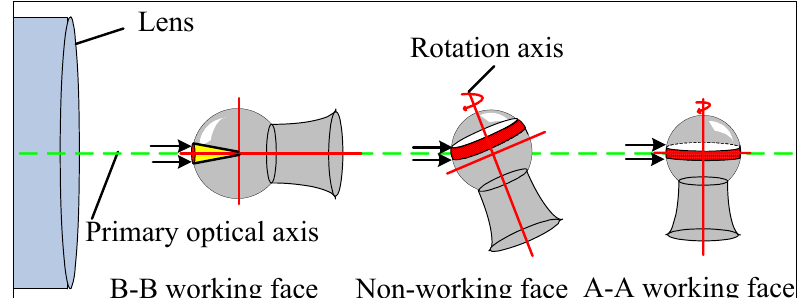
Figure 3. Detection sketch map for different working faces of pivot bearing